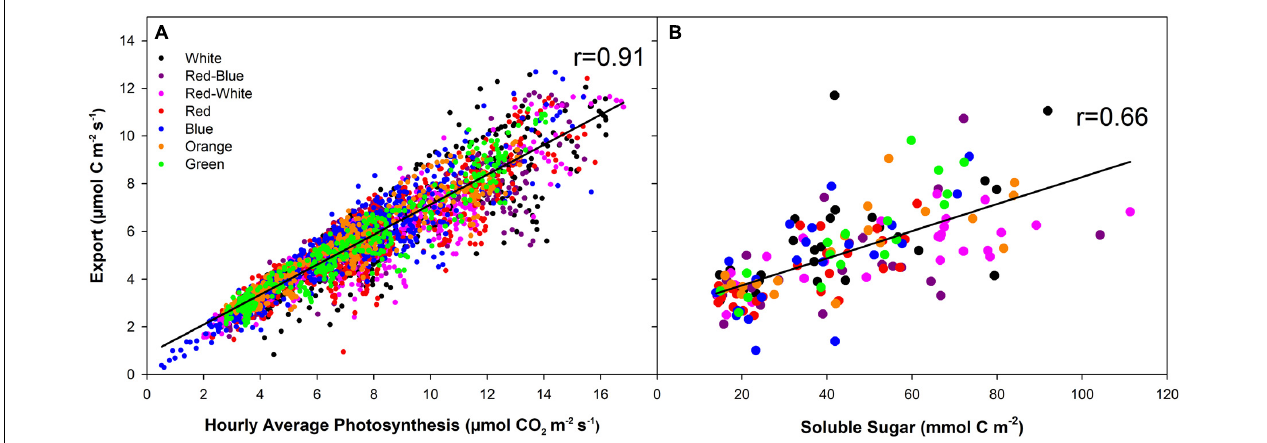
FIGURE 6 | Correlation analysis between hourly averages of carbon fixation and export under illumination with LEDs of different spectral qualities and intensities (A) . B displays the correlation between the average export during the last hour of illumination and the soluble sugar in the leaf at the end of the illumination period. The solid black line (–) indicates the linear regression line within each dataset.